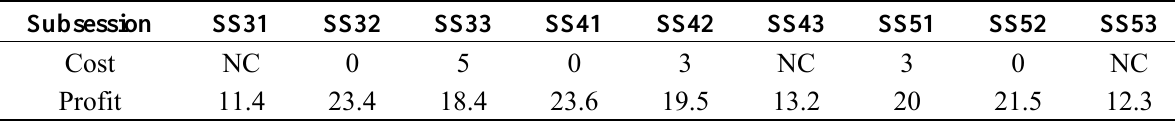
Table 3. Average